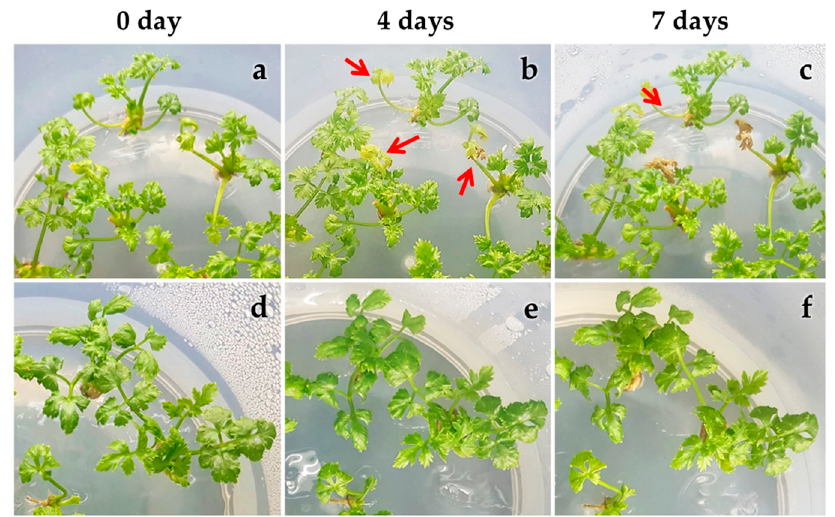
Figure 4. Effect of high-temperature treatment (32.5 °C) on the morphological changes of in vitro cultured plantlets: ( a – c ) heat-sensitive clone (clone 11; arrows indicate browning of leaves and stem branches); ( d – f ) heat-tolerant clone (clone 5). The red arrow denotes necrosis leaves and stems.